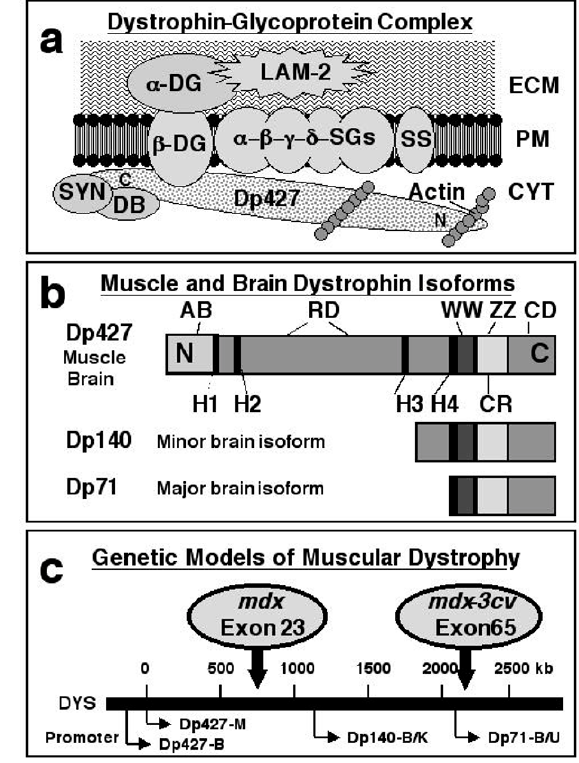
Figure 1 Diagrammatic representation of the dystrophin-glyc- oprotein complex, the structure of muscle and brain dystrophin isoforms and the genetic animal models of muscular dystrophy. In muscle, dystrophin forms a tightly associated complex with various surface components which provides a stabilizing linkage between the sub-sarco- lemmal membrane cytoskeleton and the extracellular matrix. In panel (a) is shown the proposed spatial organization of this peripheral complex consisting of dystrophin (Dp427), α -, β -, γ -, and δ -sarcoglycan (SG), the sarcolemma-spanning back- bone structure provided by α - and β -dystroglycan (DG), sar- cospan (SS), various syntrophins (SYN) and dystrobrevins (DB), as well as laminin-2 (LAM-2) and cortical actin. Panel (b) outlines the various domains of dystrophin molecules with the N-terminal actin-binding domain (AB), hinge regions (H), the central spectrin-like rod domain (RD), as well as C- terminal binding domains such as the WW domain, the ZZ domain, the cysteine-rich region (CR) and the extreme car- boxy-terminal domain (CD). While skeletal muscle fibres contain the Dp427 isoform of dystrophin, brain tissues express besides the full-length Dp427 molecule also two shorter isoforms termed Dp71 and Dp140 (b). Four of the seven promoters which drive the tissue-specific expression of dystrophins are shown in panel (c) illustrating that a point mutation in exon 23 or a mutation in exon 65 results in the absence of Dp427 in mdx mice and the absence of all brain isoforms of dystrophin in mdx -3cv